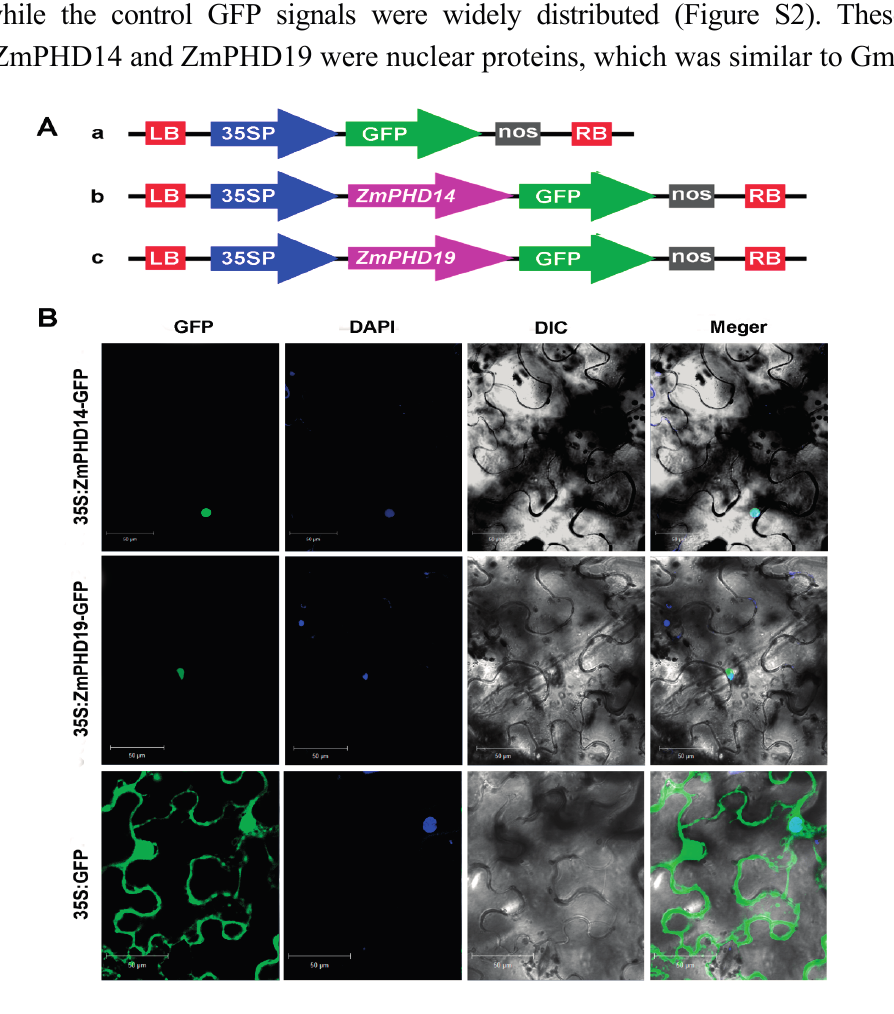
Figure 9. Subcellular localization of ZmPHD14-GFP and ZmPHD19-GFP fusion protein. ( A ) Schematic representation of the 35S:GFP, 35S:ZmPHD14-GFP and 35S:ZmPHD19-GFP fusion constructs used for transient expression; and ( B ) Fusion proteins were transiently expressed under control of the CaMV35S promoter in tobacco leaves and observed under a laser scanning confocal microscope. Green color is GFP protein signal, and blue color represents DAPI stained for nucleus. Bars = 50 μ